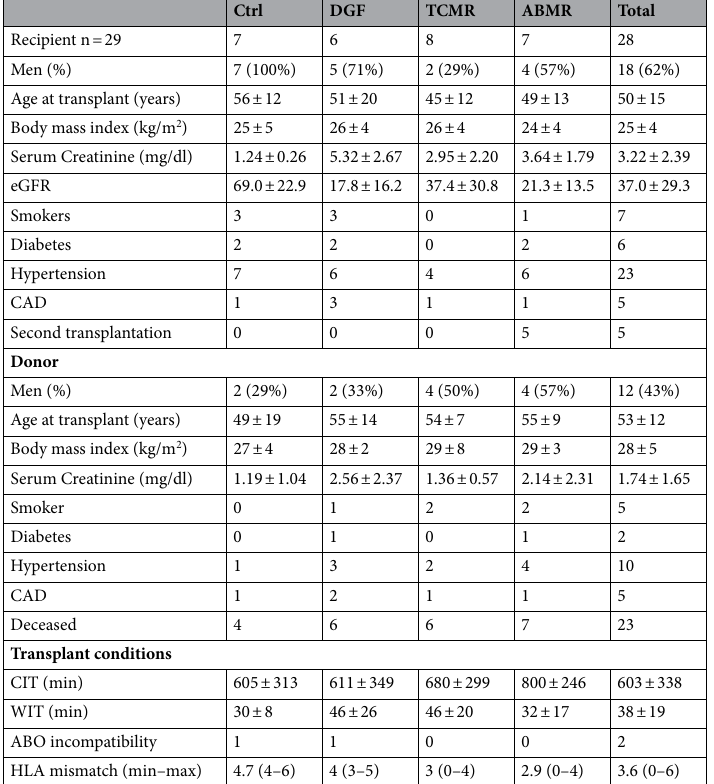
Table 1. Patient characteristics. Ctrl = control, DGF = delayed graft function, TCMR = T-cell mediated rejection, ABMR = antibody-mediated rejection, eGFR = estimated glomerular filtration ratio (according